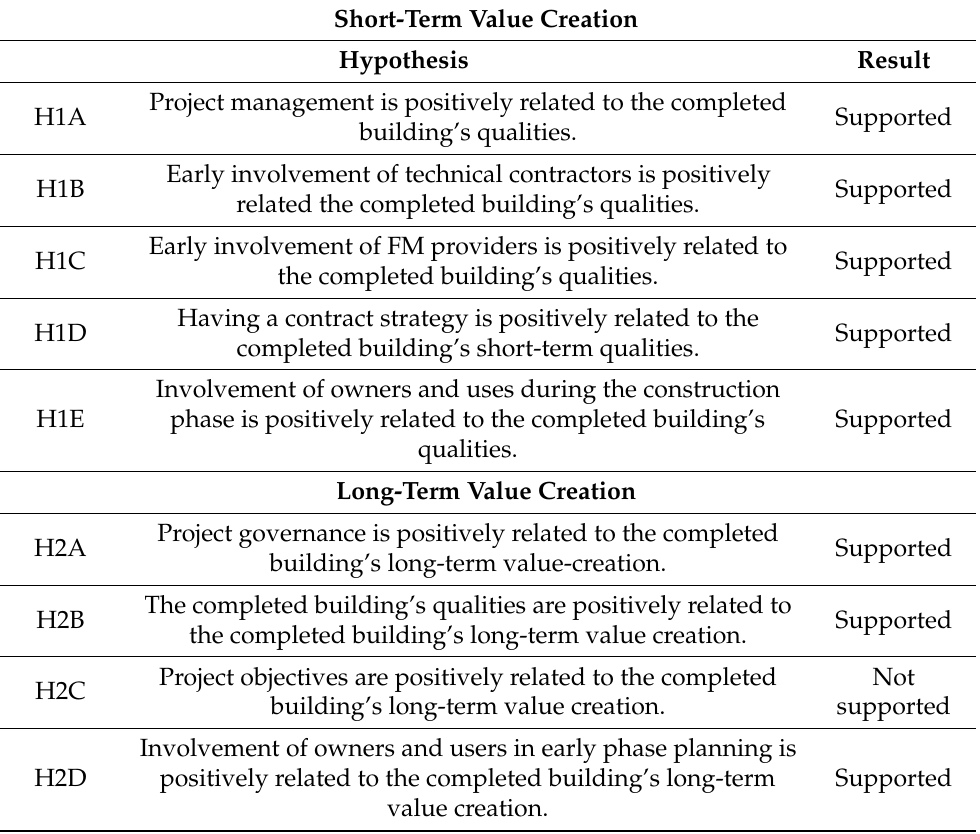
Table 9. Hypothesis testing